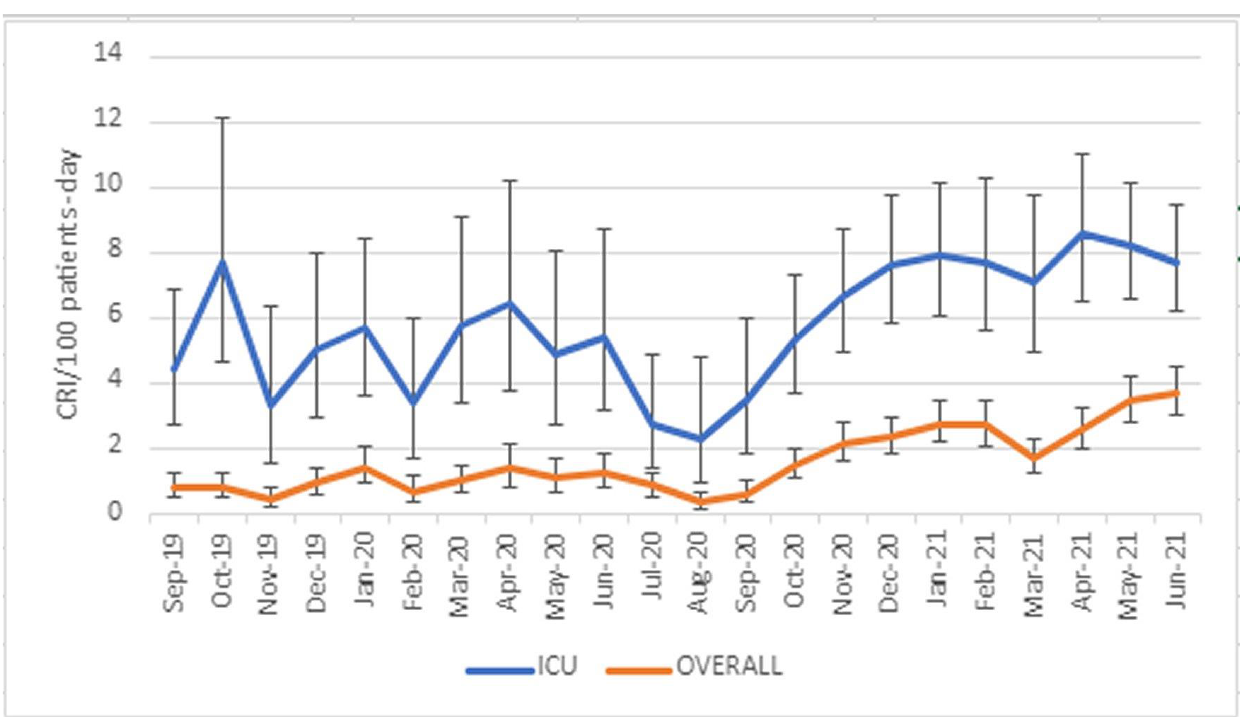
Figure 2: Temporal trends in monthly incidences of carbapenem-resistant isolates in Intensive Care Unit wards and overall. Monthly incidences of CRI per 100 patients-day (blu and red lines) with 95% CI (black lines). CRI: Carbapenem-resistant isolates; ICU: Intensive Care